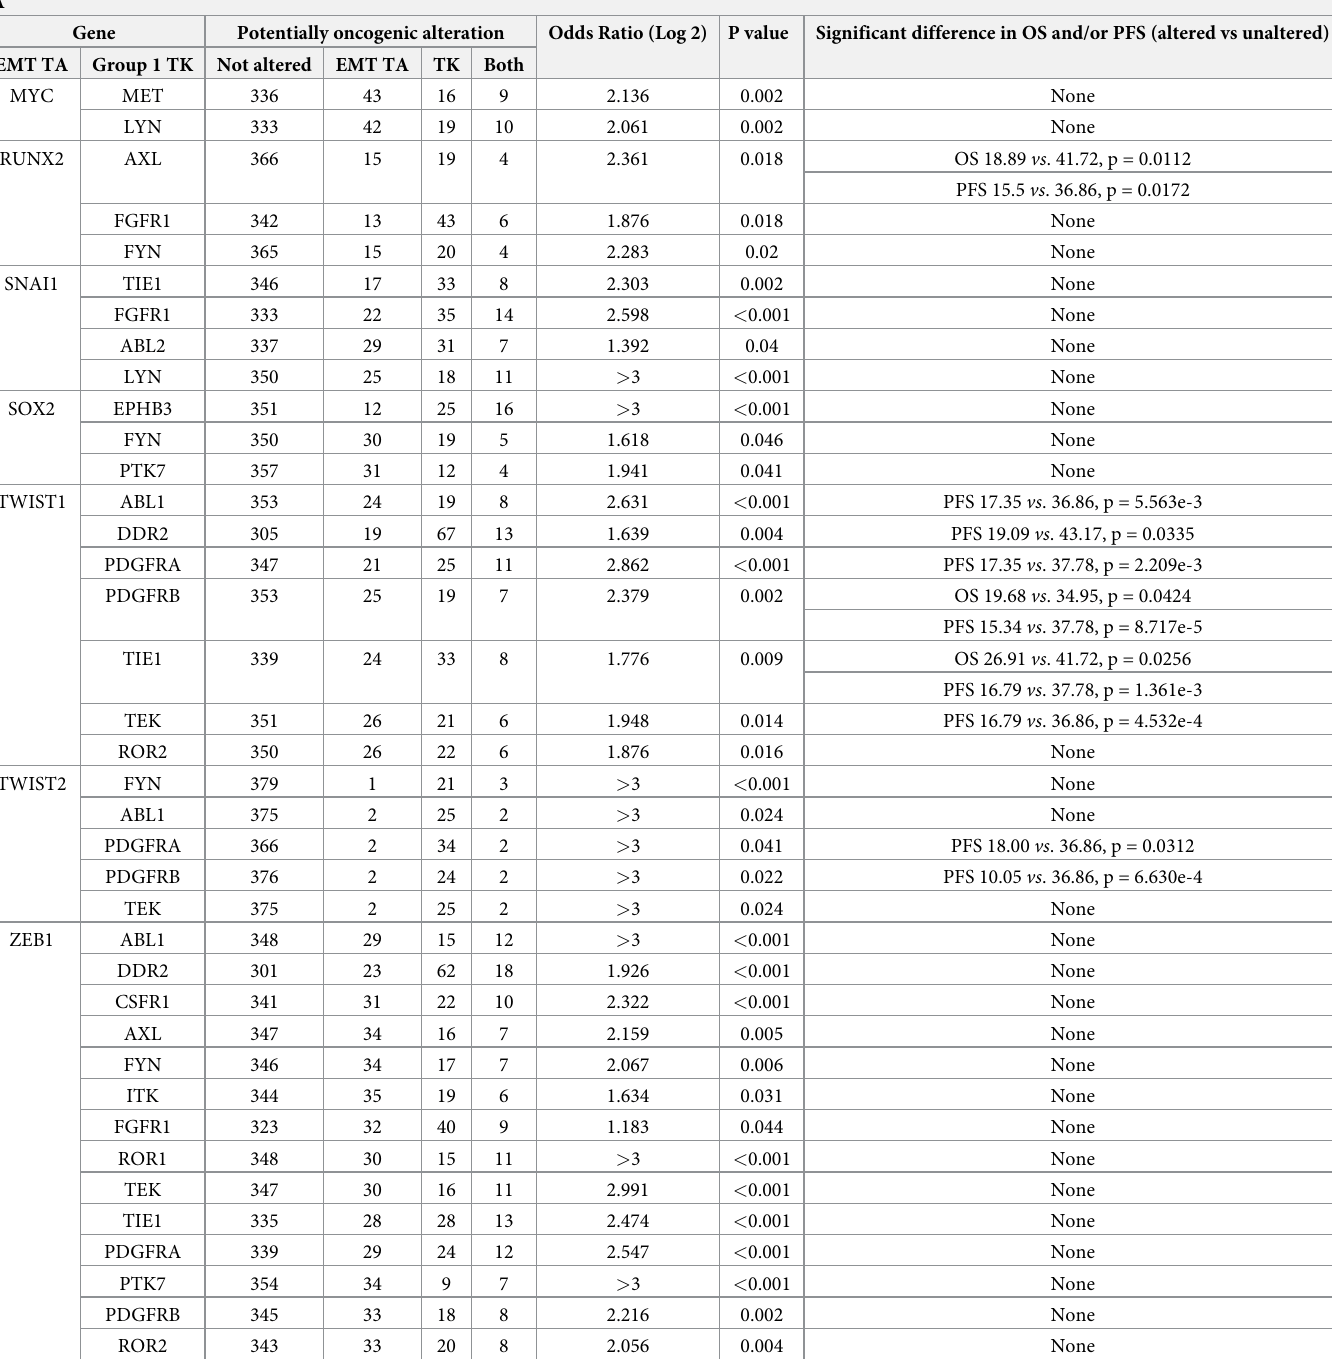
Table 5. (A) Significant co-occurrence of potentially oncogenic alteration (overexpression > 2-fold, and/or gene amplification) for Group 1 TKs and EMT TAs in TCGA dataset (n = 408) [22] and associated median OS and PFS. (B) Significant co-occurrence of potentially oncogenic alteration (overexpression > 2-fold, and/or gene amplification) for Group 2 TKs and EMT TAs in TCGA dataset (n = 408) [22] and associated median OS and